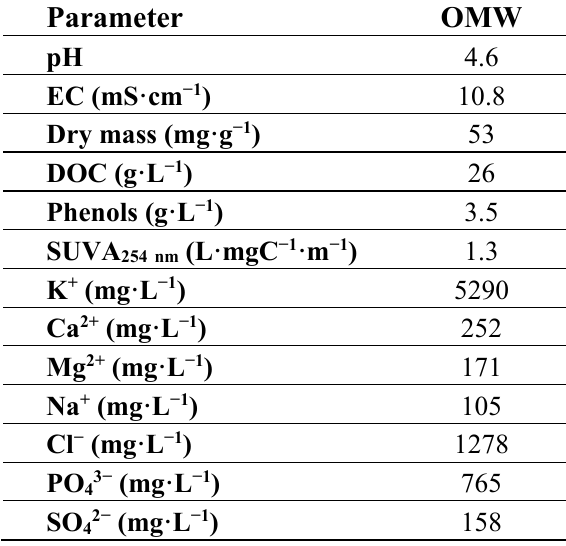
Table 1. Characteristics of OMW from Bait Reema used for application in both fields [13]. Errors are within the last digit of each